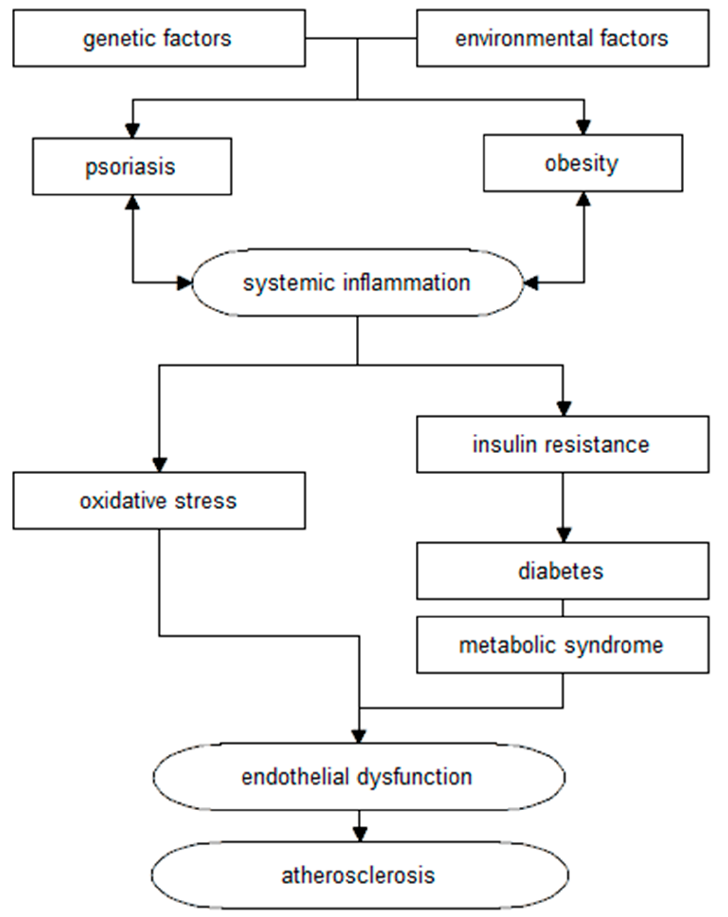
Figure 2. Diagram of the relationship between psoriasis and cardiovascular disease, according to the “psoriasis march” concept (own elaboration based on [1,17]).